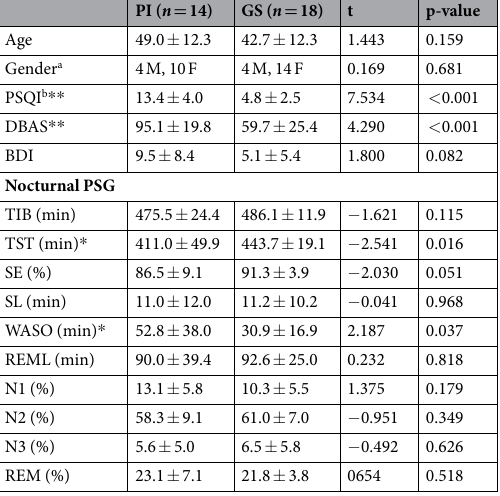
Table 1. Comparison of clinical variables between the psychophysiological insomnia (PI) and good sleeper (GS) groups (df = 30). Note: Independent t -test, a χ 2 test, b Scores ≥ 8.5 on the Korean version of the PSQI indicate poor